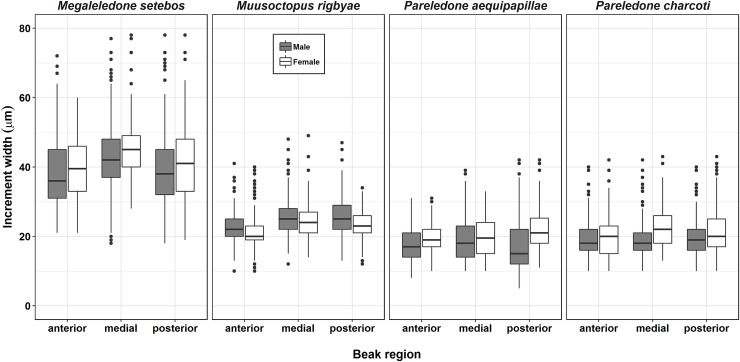
Increment width in different regions of the lateral walls of the octopus beaks analyzed.The anterior region indicates the oldest portion close to the rostrum while the posterior region bear recent formed increments near to the edge of the crest.